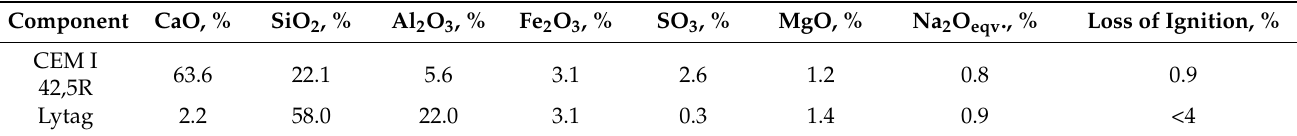
Table 3. Chemical composition of the cement and the sintered fly ash.